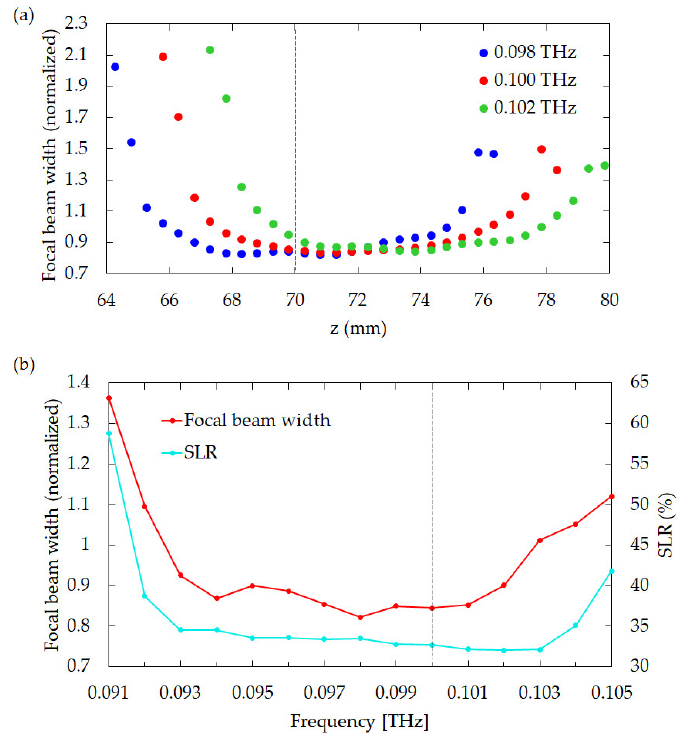
Figure 7. Frequency dependence of the THz-CSOL. ( a ) Beam widths of the transmitted THz wave by the CSOL at different frequencies: 0.098 THz (blue), 0.100 THz (red), and 0.102 THz (green). The black dashed line is the designed focal length, 70 mm. ( b ) Comparison of beam widths at z = 70 mm when the CSOL is used for a range of different frequencies (0.095 THz – 0.105 THz). Red dots with lines represent the normalized beam widths while cyan-colored dots with lines represent the SLR. The black dashed line indicates the frequency (0.100 THz) for which the design of the CSOL was optimized.